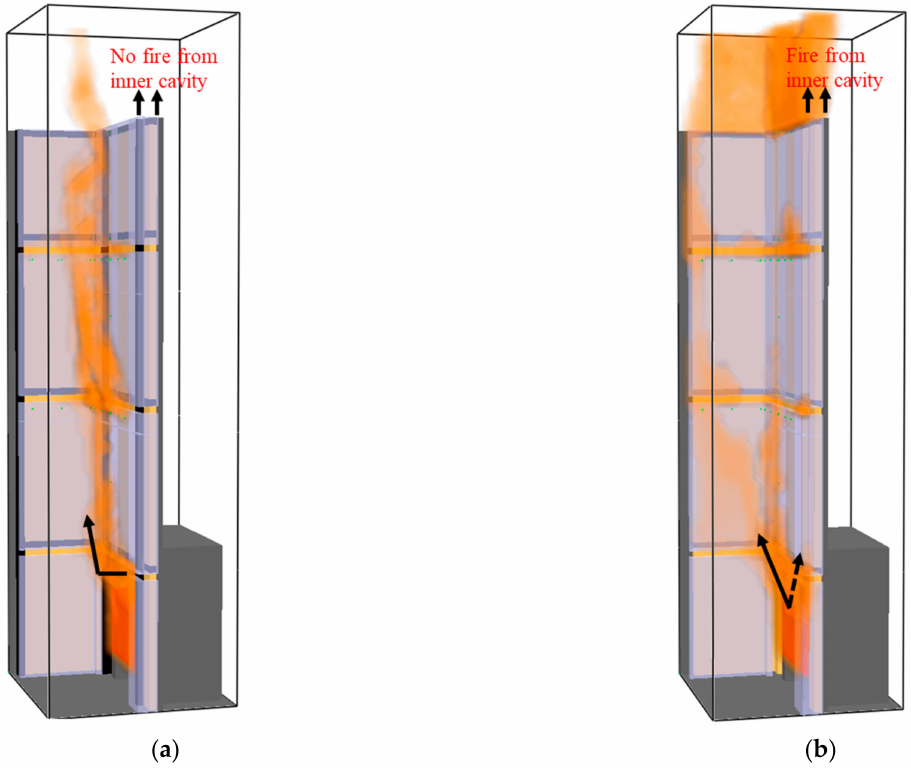
Figure 10. Effect of cavity barrier under full-scale test (BS 8414-1) fire simulation. ( a ) With cavity barrier at 400 s (scenario S1), ( b ) Without cavity barrier at 400 s (scenario